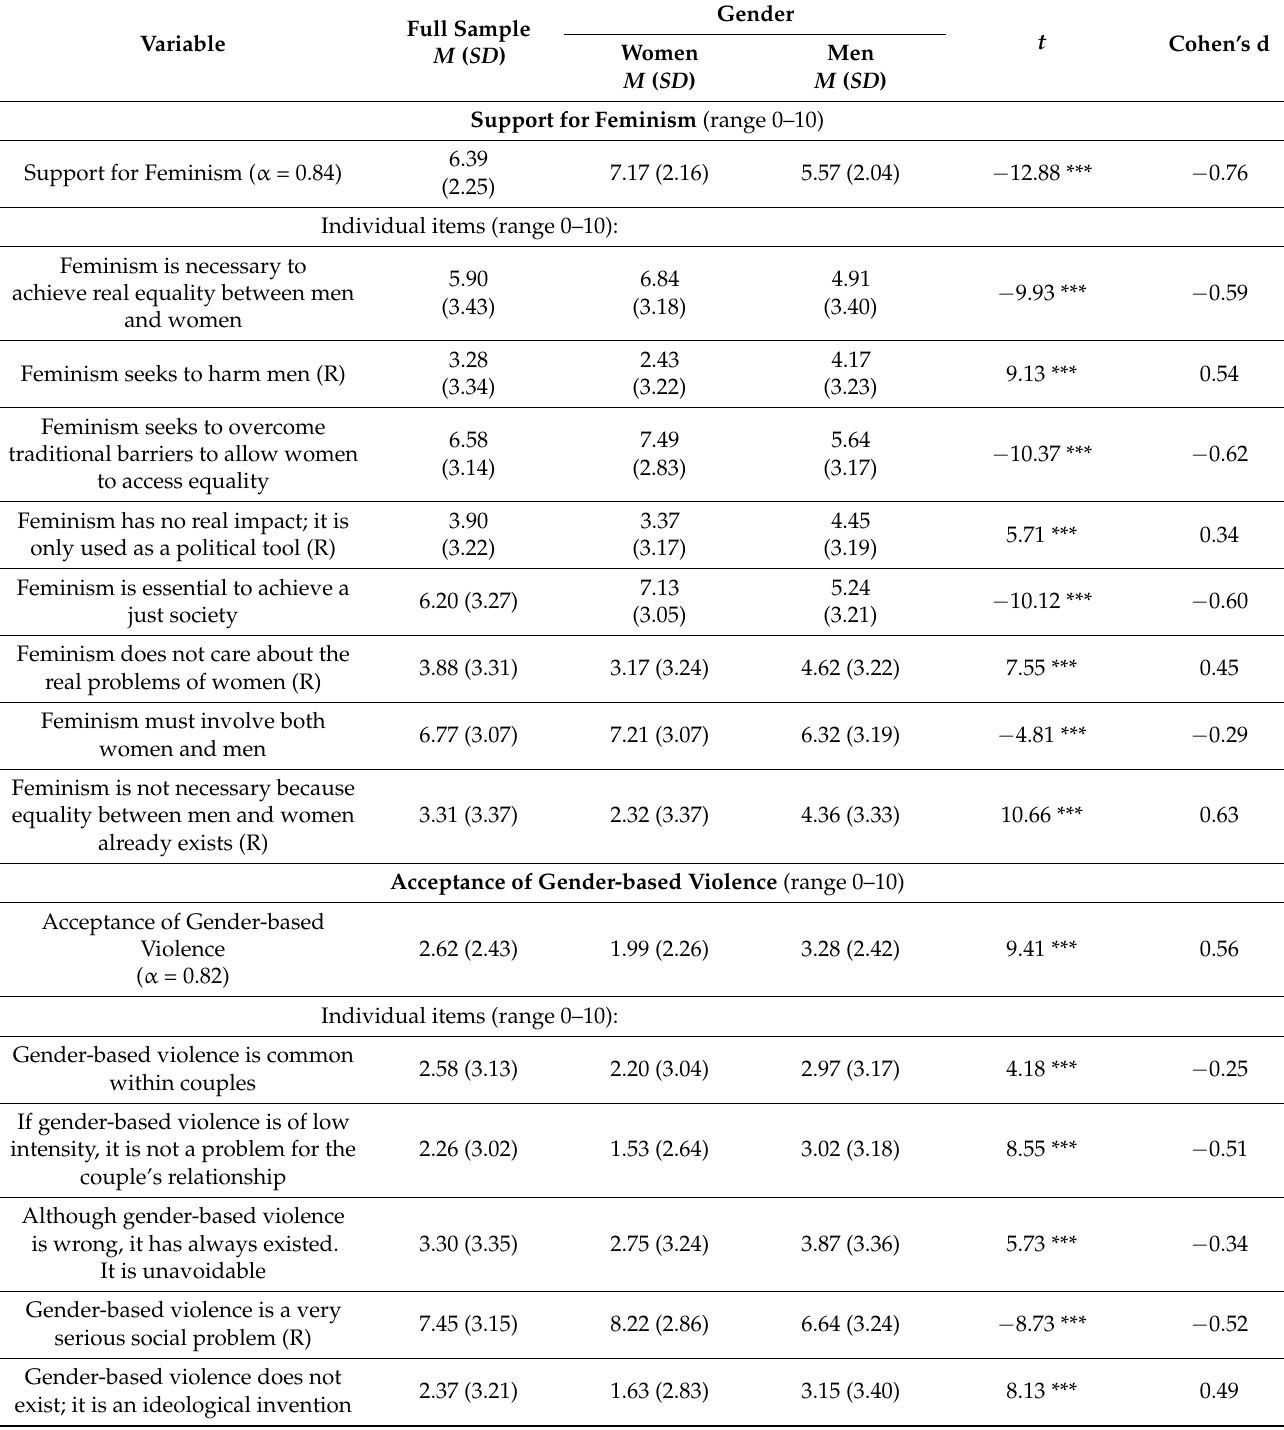
Table 5. Descriptive statistics of the support for feminism and acceptance of gender-based violence variables by